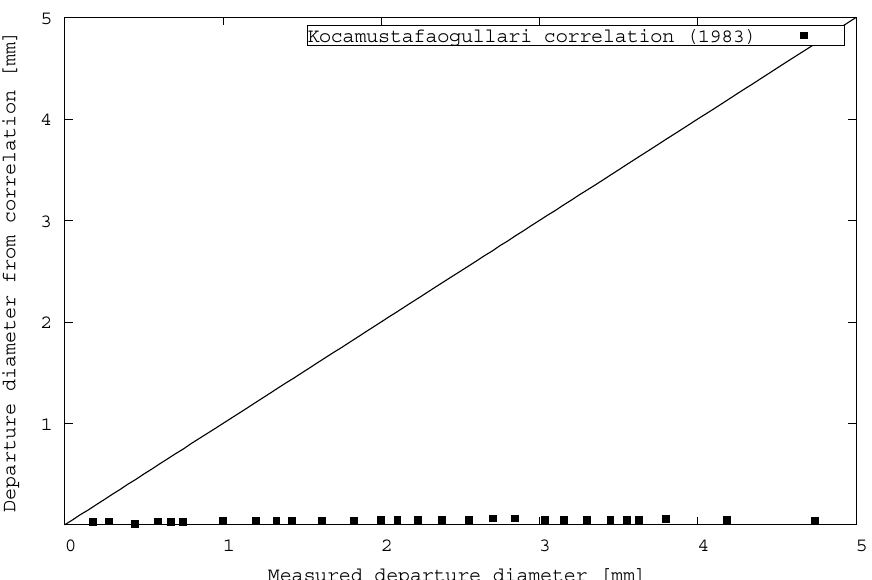
Figure 3. Comparison between bubble departure diameters generated with the popular correlation of Kocamustafaogullari [21], widely used in Rensselaer Polytechnic Institute (RPI) modelling of wall boiling, and measured bubble departure diameters in conditions of the work in [20].